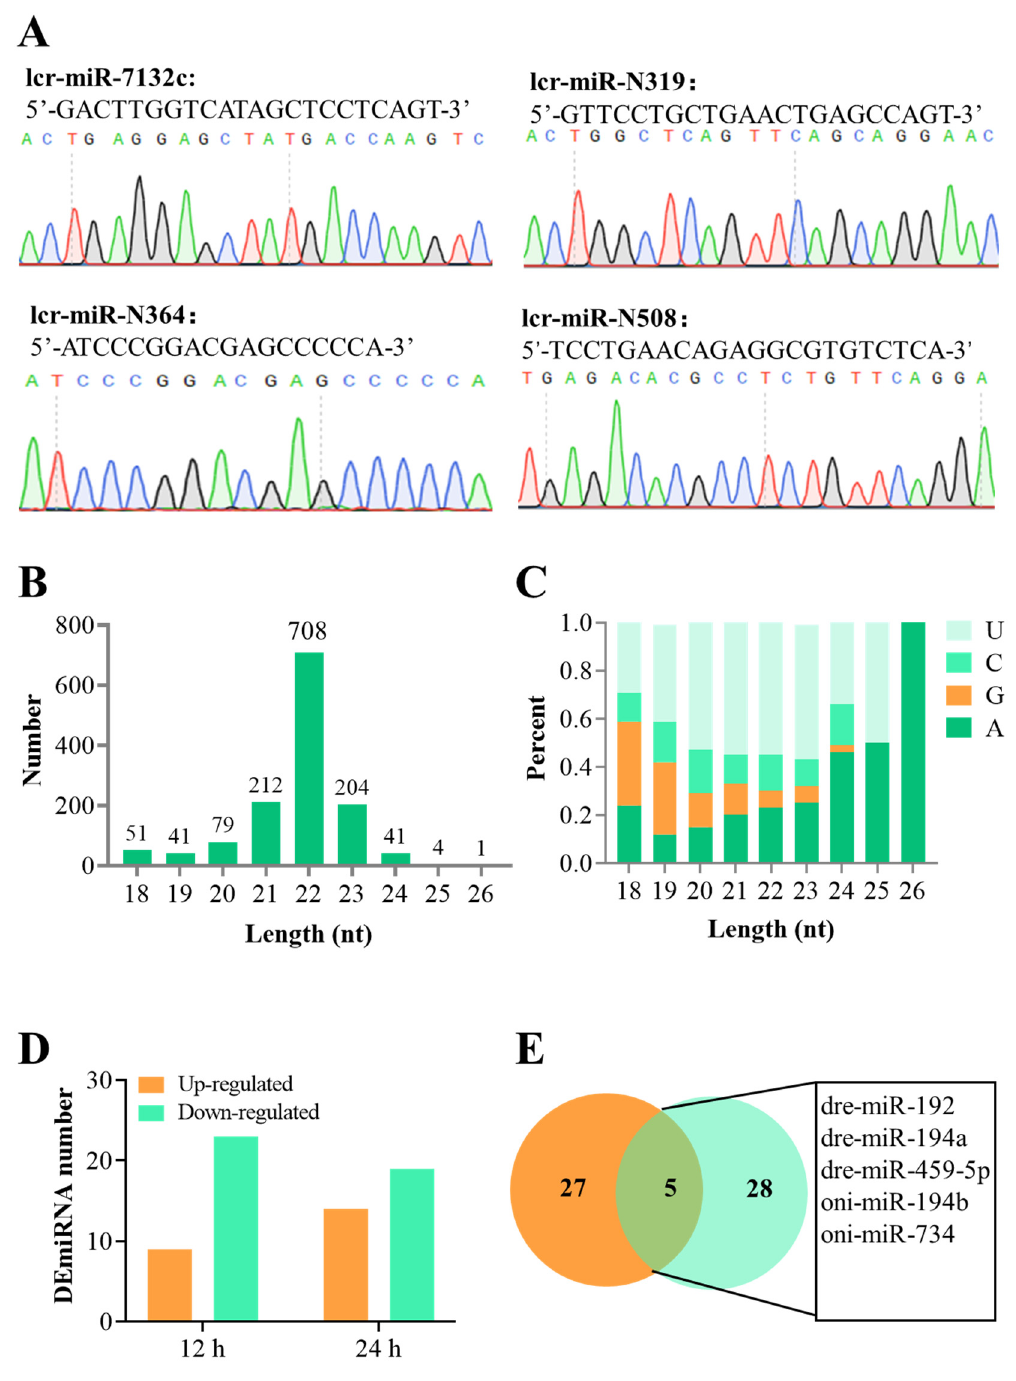
Figure 1. Overview of the small RNA-seq data. ( A ) Sanger sequencing validation of the novel miRNAs lcr-miR-7132c, lcr-miR-N319, lcr-miR-N364, and lcr-miR-N508. ( B ) Length distributions of the miRNAs from the L. crocea spleen. ( C ) Relationship between first nucleotide bias and miRNA length in the L. crocea spleen. ( D ) The number of miRNAs differentially expressed in the spleens of L. crocea challenged with P. plecoglossicida as compared to the control at 12 h and 24 h after injection. ( E ) Venn diagram showing the unique and shared DEmiRNAs at 12 h (orange) and 24 h (green) after injection.